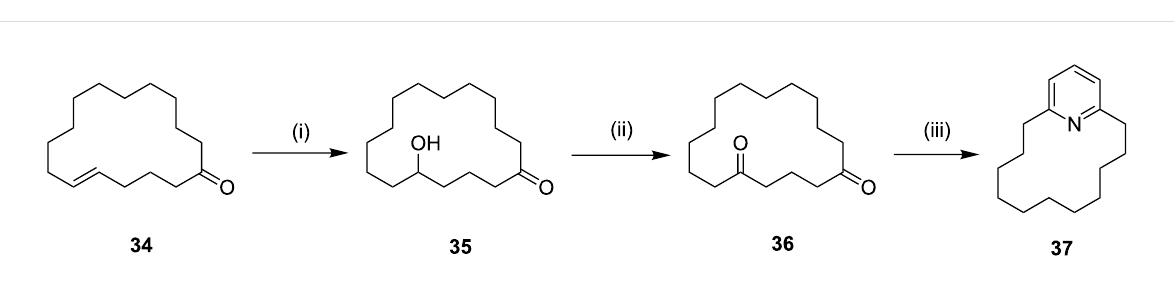
Scheme 3: Synthesis of normuscopyridine analogue 37 through an oxymercuration–oxidation strategy. Reagents and conditions: (i) Hg(OAc) 2 , NaSH; (ii) oxidation; (iii) NH 2 OH·HCl.